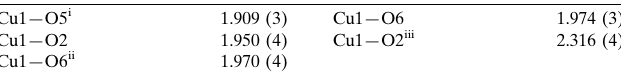
Selected bond lengths (A˚